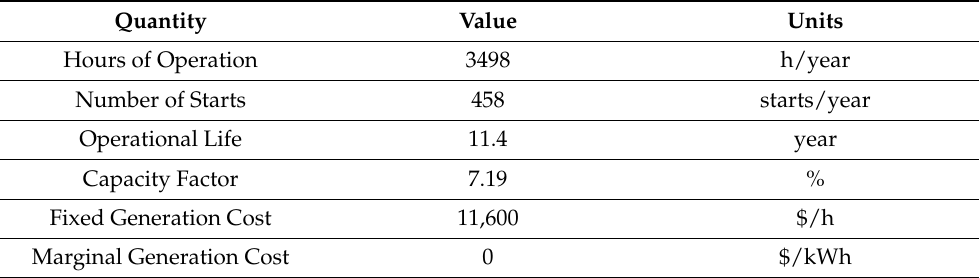
Figure 8. Average consumption of hydrogen (kg/h) for each month.